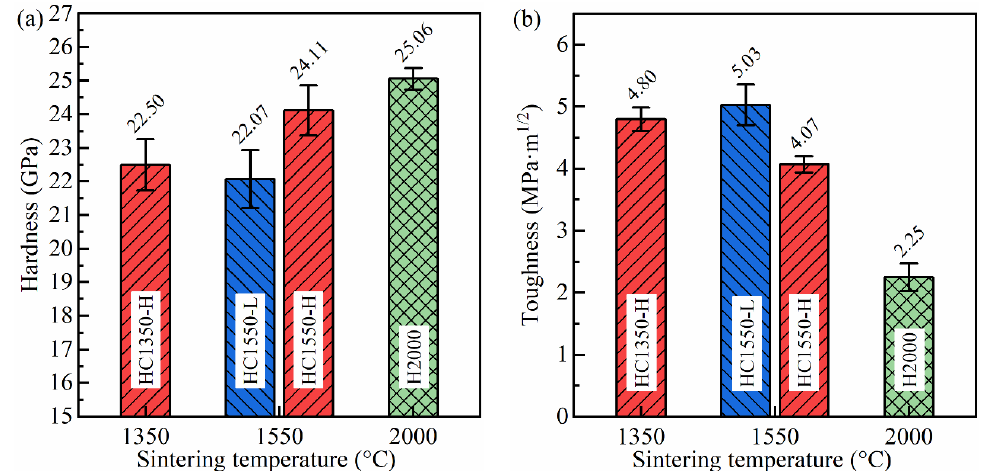
Fig. 9 Mechanical properties of the SPS processed samples: (a) Vickers hardness and (b) fracture